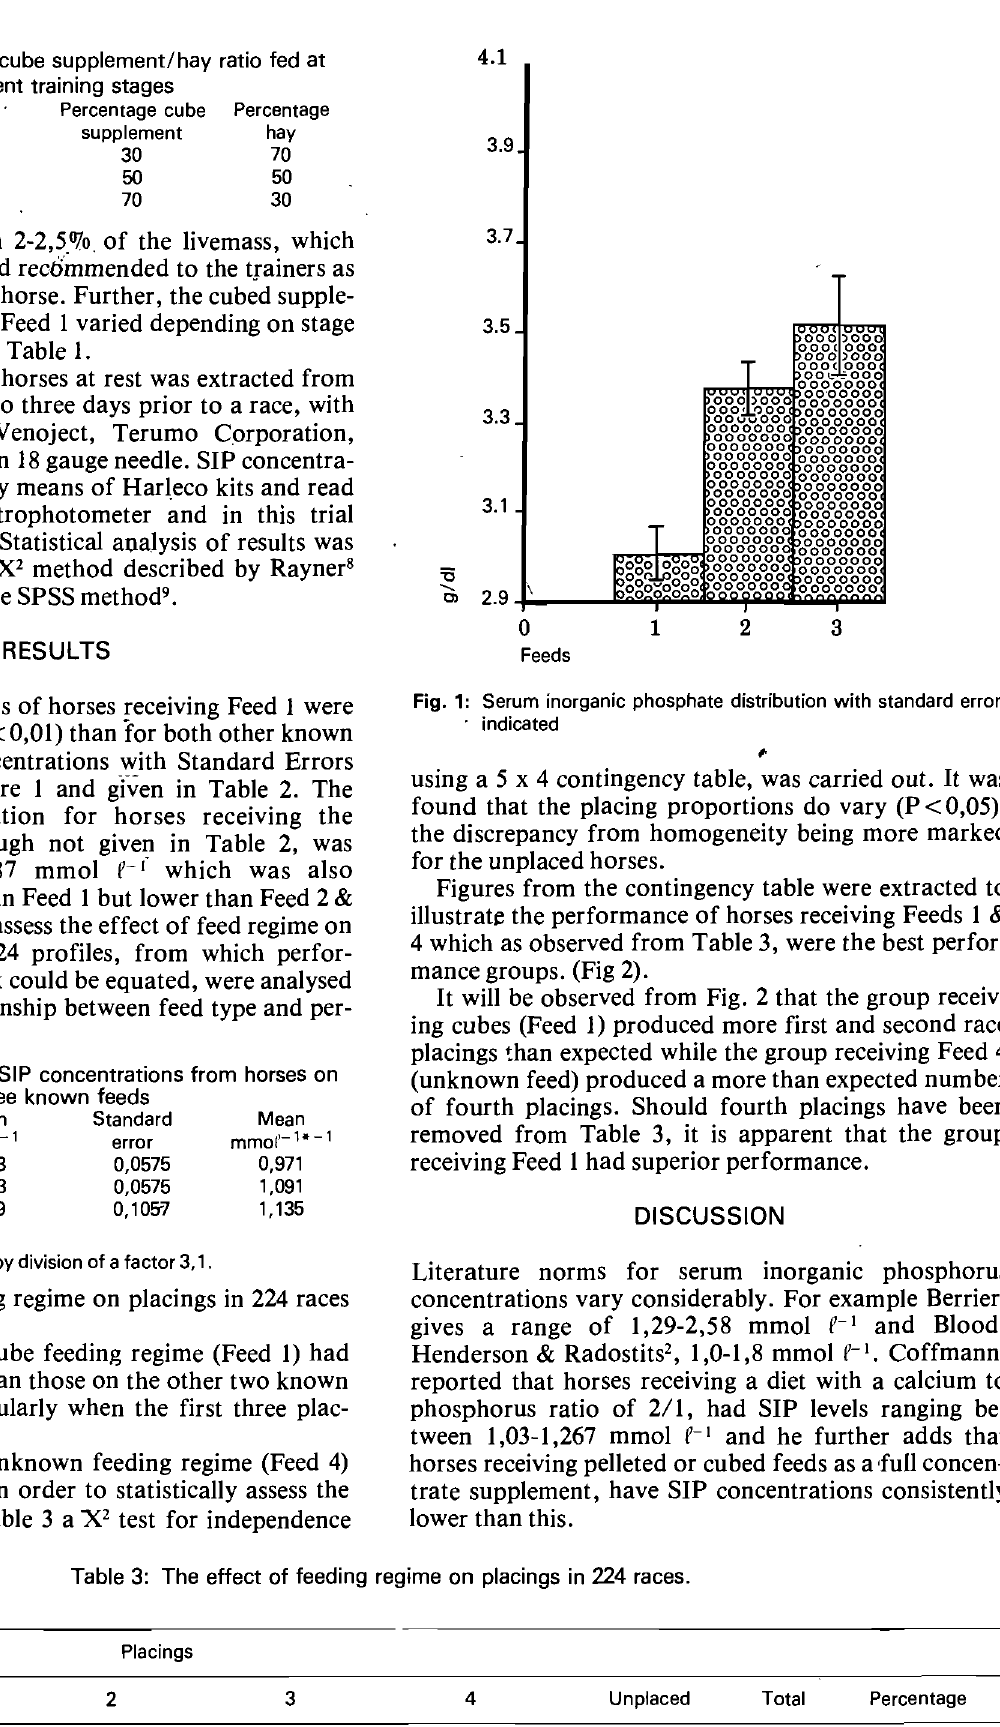
Table 3: The effect of feeding regime on placings in 224